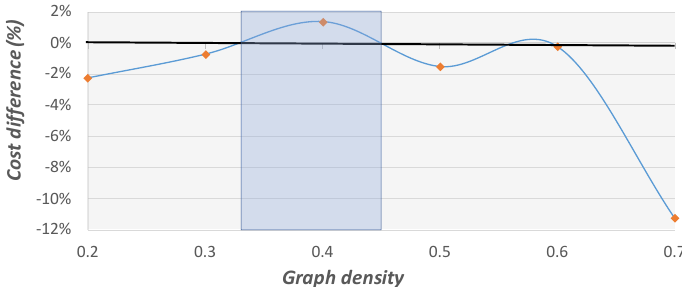
Figure 18. Cost difference comparison on graphs with 200 vertices at different densities. This graph presents the average cost difference between the GA’s solutions and those of the 2-factor approximation method, which are marked by the fixed black line. The blue region represents graph densities in which the 2-factor approximation method finds better solutions.